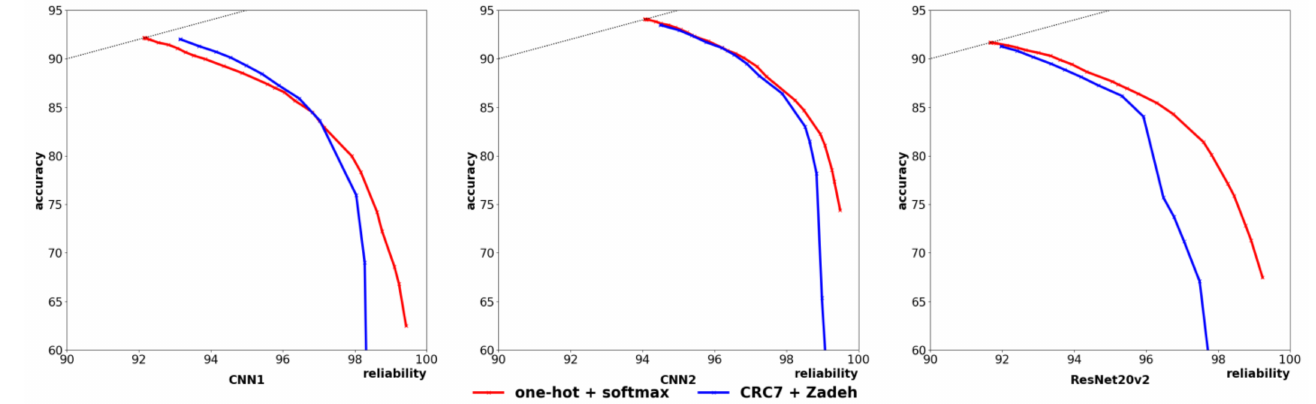
Figure 3. Accuracy–reliability characteristics for different network architectures.